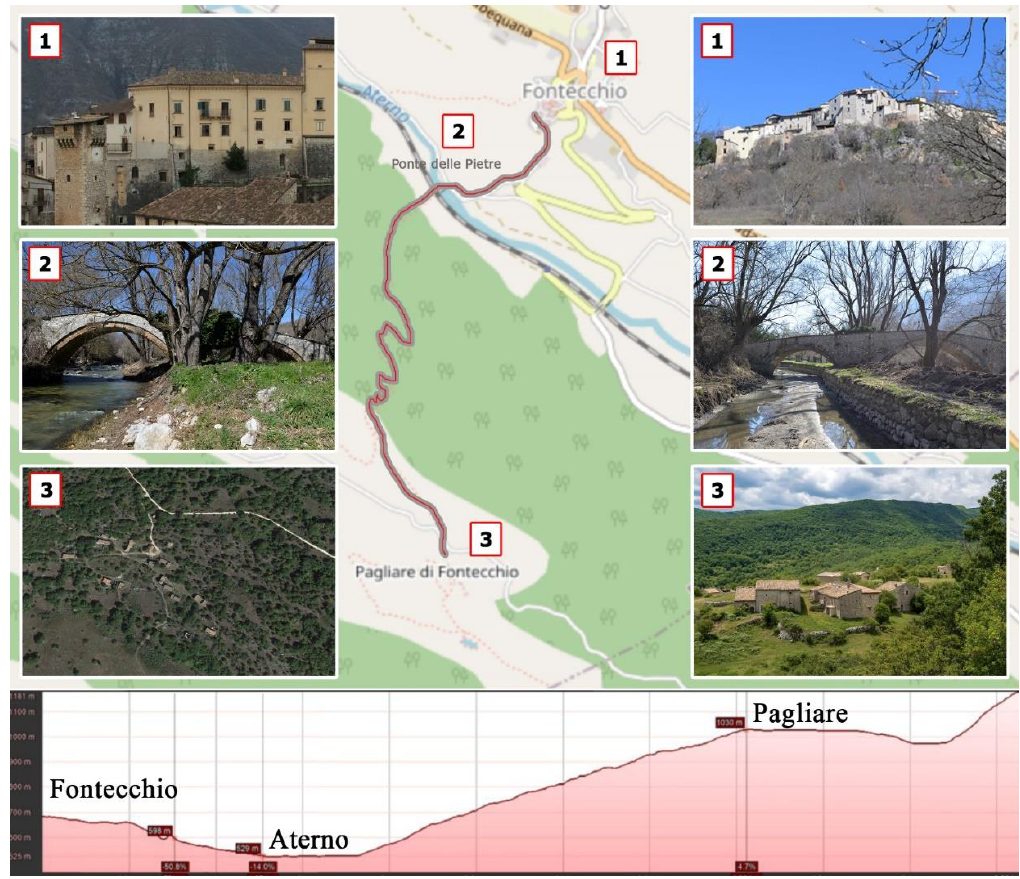
Figure 1 . General view of the area analysed with some images of its cultural